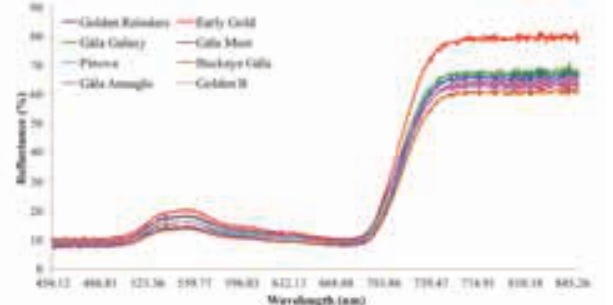
Figure 1. Spectral profiles of the apple species